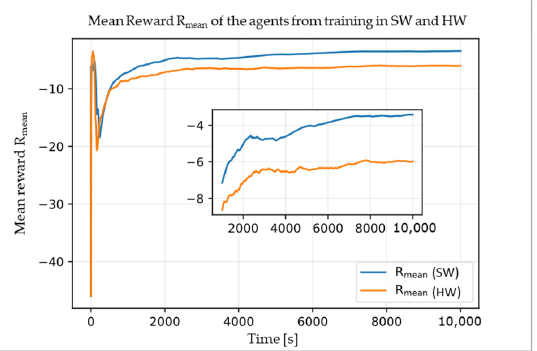
Figure 5. Mean reward R mean of the agents increasing throughout training in software (SW) and hardware (HW). hardware